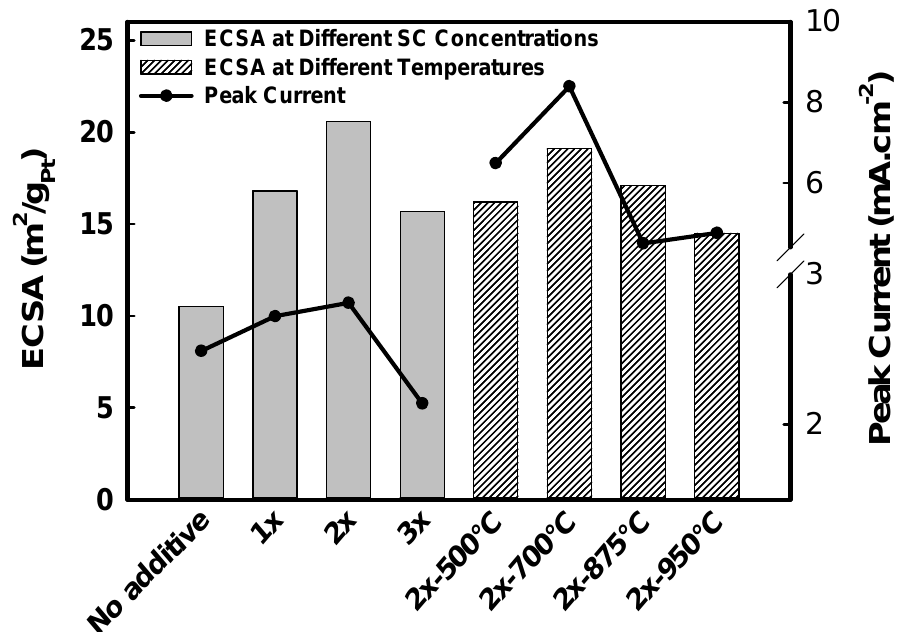
Figure 10. ECSA changes at different SC concentrations and after heat treatment at different temperatures, measured from Figure 9, and the ethanol oxidation peak current, measured from Figure